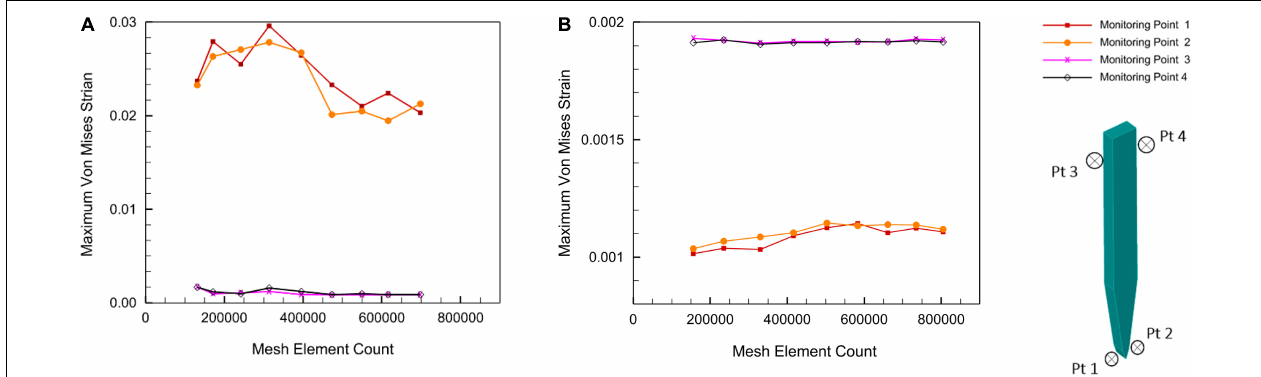
FIGURE 5 | Mesh sensitivity analysis at a displacement of 1 µ m. (A) Stiff silicon probe; (B) compliant PVAc-NC probe.